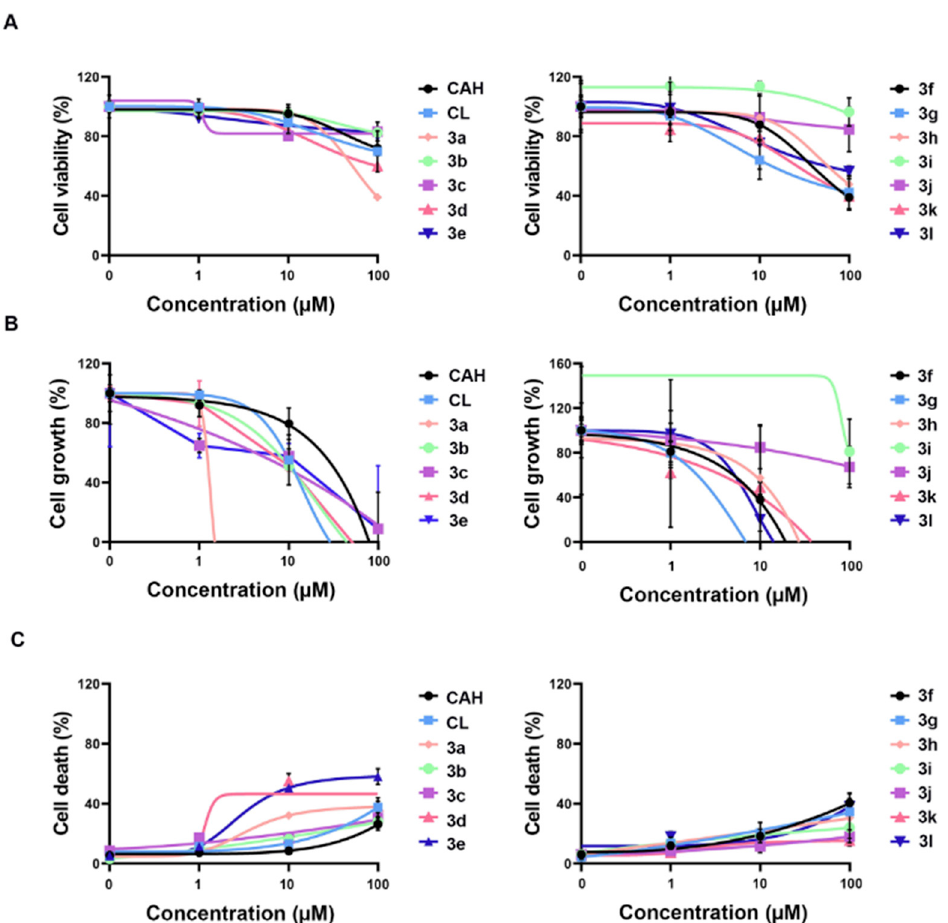
Figure 2. In vitro efficacy of CAH derivatives 3a – 3l using therapeutic indices in SW10 cells treated with 1–100 µ M of each compound for 10 h. ( A ) Dose–effect curve plot of 3a – 3l indicated the cell viability of SW10 cells. ( B ) Cell growth curves of 3a – 3l representing inhibition of cell proliferation were determined by the MTS assay in a dose-dependent manner. ( C ) Cell death was calculated as a ratio of live cells over dead cells via trypan blue exclusion assay. All CAH derivatives showed no in vitro efficacy in concentrations of ≤ 100 nM and 100% cell death in the concentration of 1 mM, respectively. CAH, cinnamaldehyde. CL, chalcone.